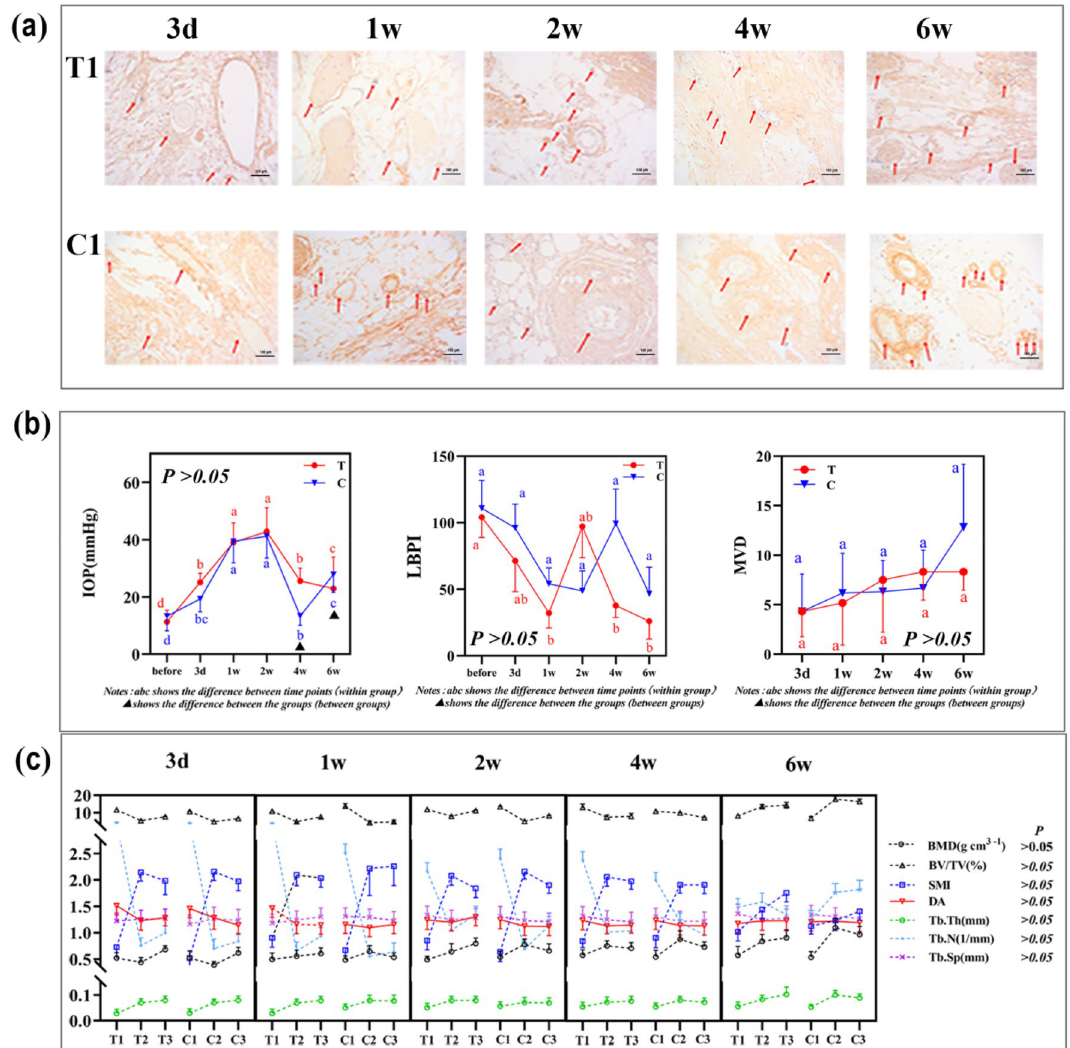
Figure 2. The variation of implant surface morphology had no impact on the intraosseous pressure (IOP), local blood perfusion index (LBPI), or microvessel density (MVD). ( a ) Histopathological images of the newly formed microvessel next to the titanium implants at a magnification of 200 × . The red arrows indicate the newly formed microvessel. ( b ) There was no significant difference in IOP and MVD between groups T and C ( P > 0.05). ( c ) The major microstructure parameters of the new bone formed surrounding the implants of groups T and C showed no statistical differences. The statistical significance was set at P < 0.05. This figure was generated by Adobe photoshop CC the T1 or C1 implants. Statistical analysis showed no significant differences in the IOP, LBPI, and MVD values of groups T and C ( P > 0.05, Fig. 2b). The IOP diagram showed that there were differences between groups T and C ( P < 0.05) 4 and 6 w after implantation, but there was no overall significant difference between the two groups ( P > 0.05). Figure 2c shows that were no significant differences in terms of bone mineral density (BMD), bone volume fraction (BV/TV), structure model index (SMI), degree of anisotropy (DA), trabecular number (Tb.N), trabecular thickness (Tb.Th), and trabecular separating spacing (Tb.Sp) of the new bone formed surrounding the implants between groups T and C ( P > 0.05). Among those parameters, the BMD values of T1 and C1 were significantly lower than those of T2, T3, C2, and C3 ( P < 0.05). The SMI values of T1 and C1 were 45% and 41%, respectively, as those of T2, C2, T3, and C3 ( P > 0.05). The Tb.N values of T1 and C1 were significantly lower, by 55% and 51%, respectively, than T2, T3, C2, and C3 Tb.N values ( P < 0.05). Cell movement assessment. Changes in surface micromorphology are affected by CMV, but not CMA. Figure 3a shows the tissue-on-a-chip design consisting of acellular canine alveolar bone (ACAB), ti- tanium sheet T or C, and polydimethylsiloxane (PDMS). Scanning electron microscopy (SEM) images showed that the cells in cancellous bone cavities had already been removed. The flow channel and the middle chamber simulated blood diffusion from the inferior alveolar artery into the surrounding bone tissue. As indicated in